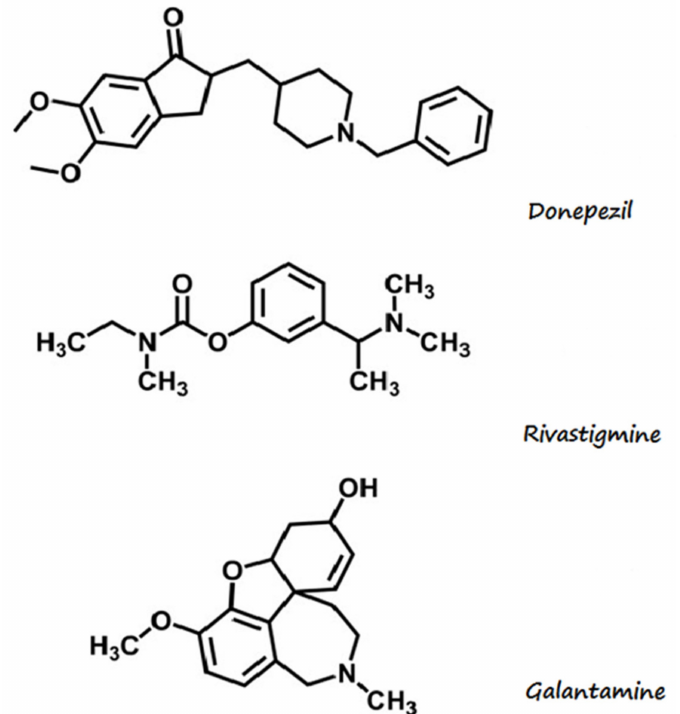
Figure 1. Structural formulas of cholinesterase inhibitors. Based on Nadri et al. [12]. O, oxygen; N, nitrogen; CH 3 , methyl